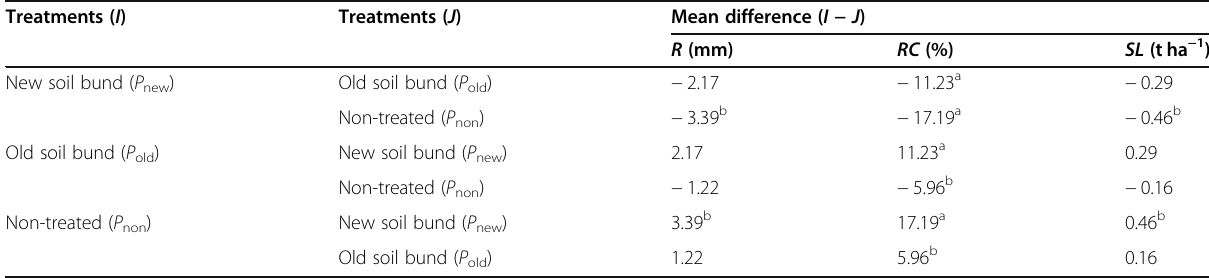
Table 3 Multiple comparisons of mean differences of runoff ( R ), runoff coefficient ( RC ), and soil loss ( SL ) between the three